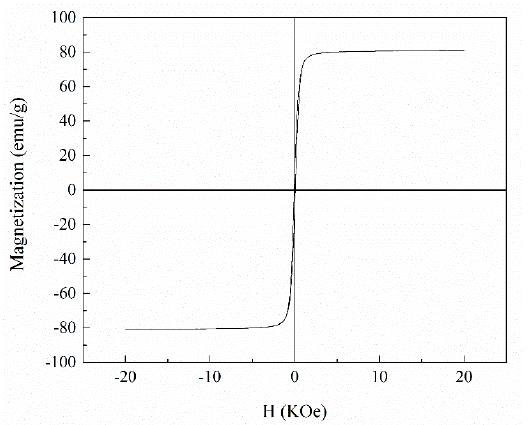
Figure 2. Magnetization curve of Fe 3 O 4 nanoparticles.